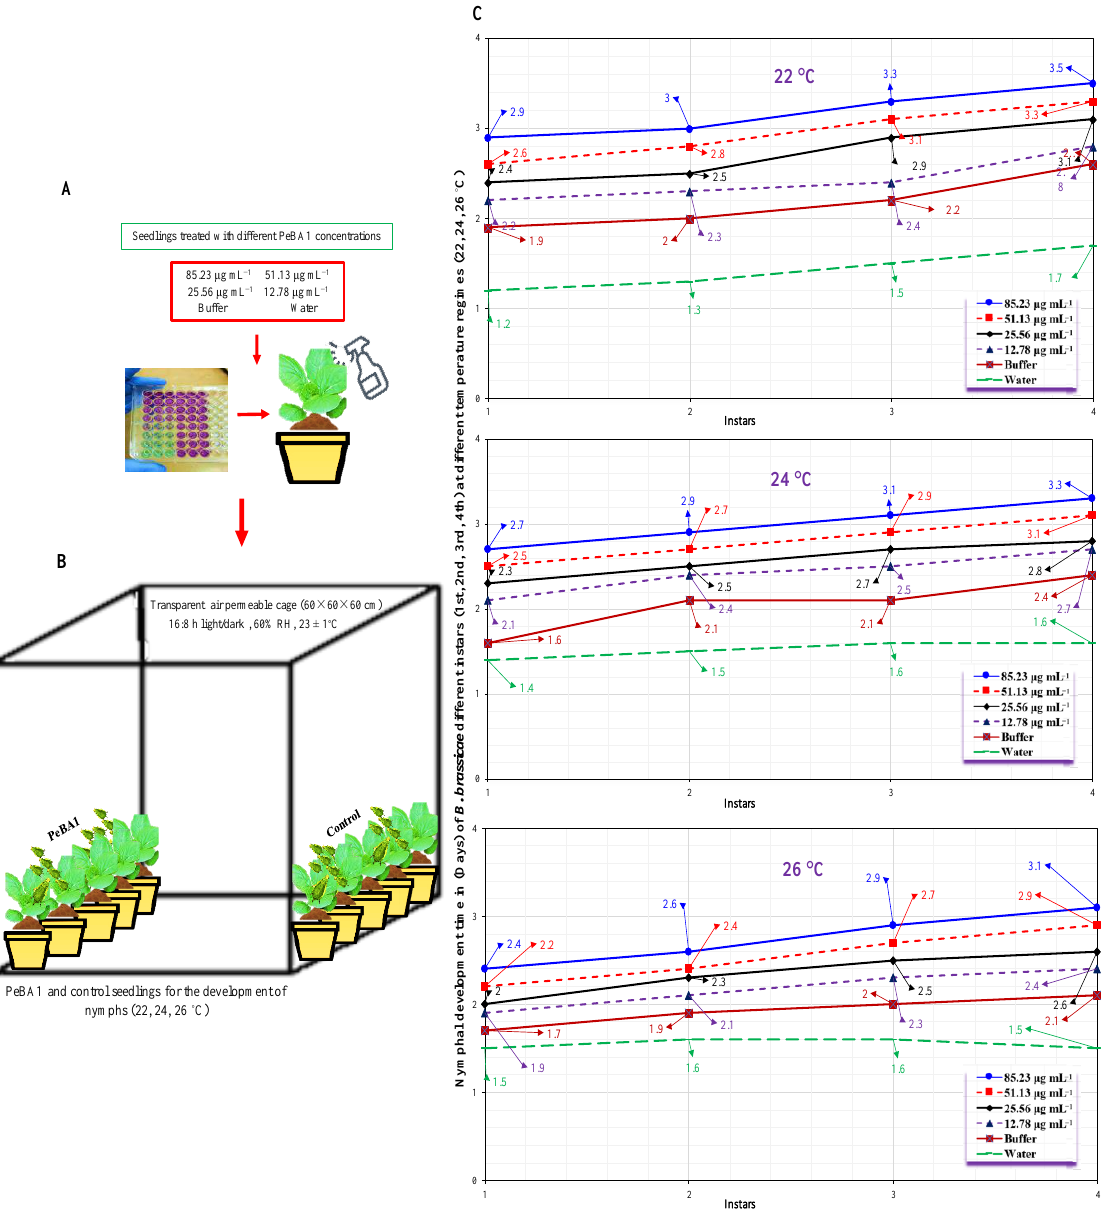
Figure 5. Mean developmental time ( ± SE) of B. brassicae nymphal instars on B. rapa plants in varying concentrations at 22, 24, 26 ◦ C ( n = 10). Seeds and seedlings treatment and preparation for inoculation B. brassicae ( A , B ). Nymph development time prolonged in treated seedlings compared to control, ( C ). Data were compared statistically using a factorial ANOVA and the least significant difference (LSD) at α = 0.05.